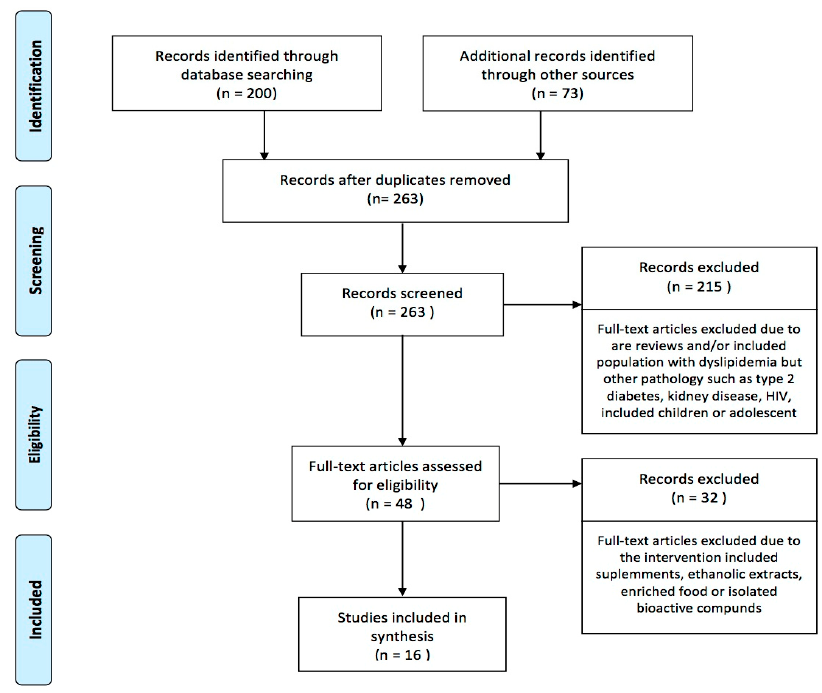
Figure 1. Flow chart (PRISMA) of studies included.